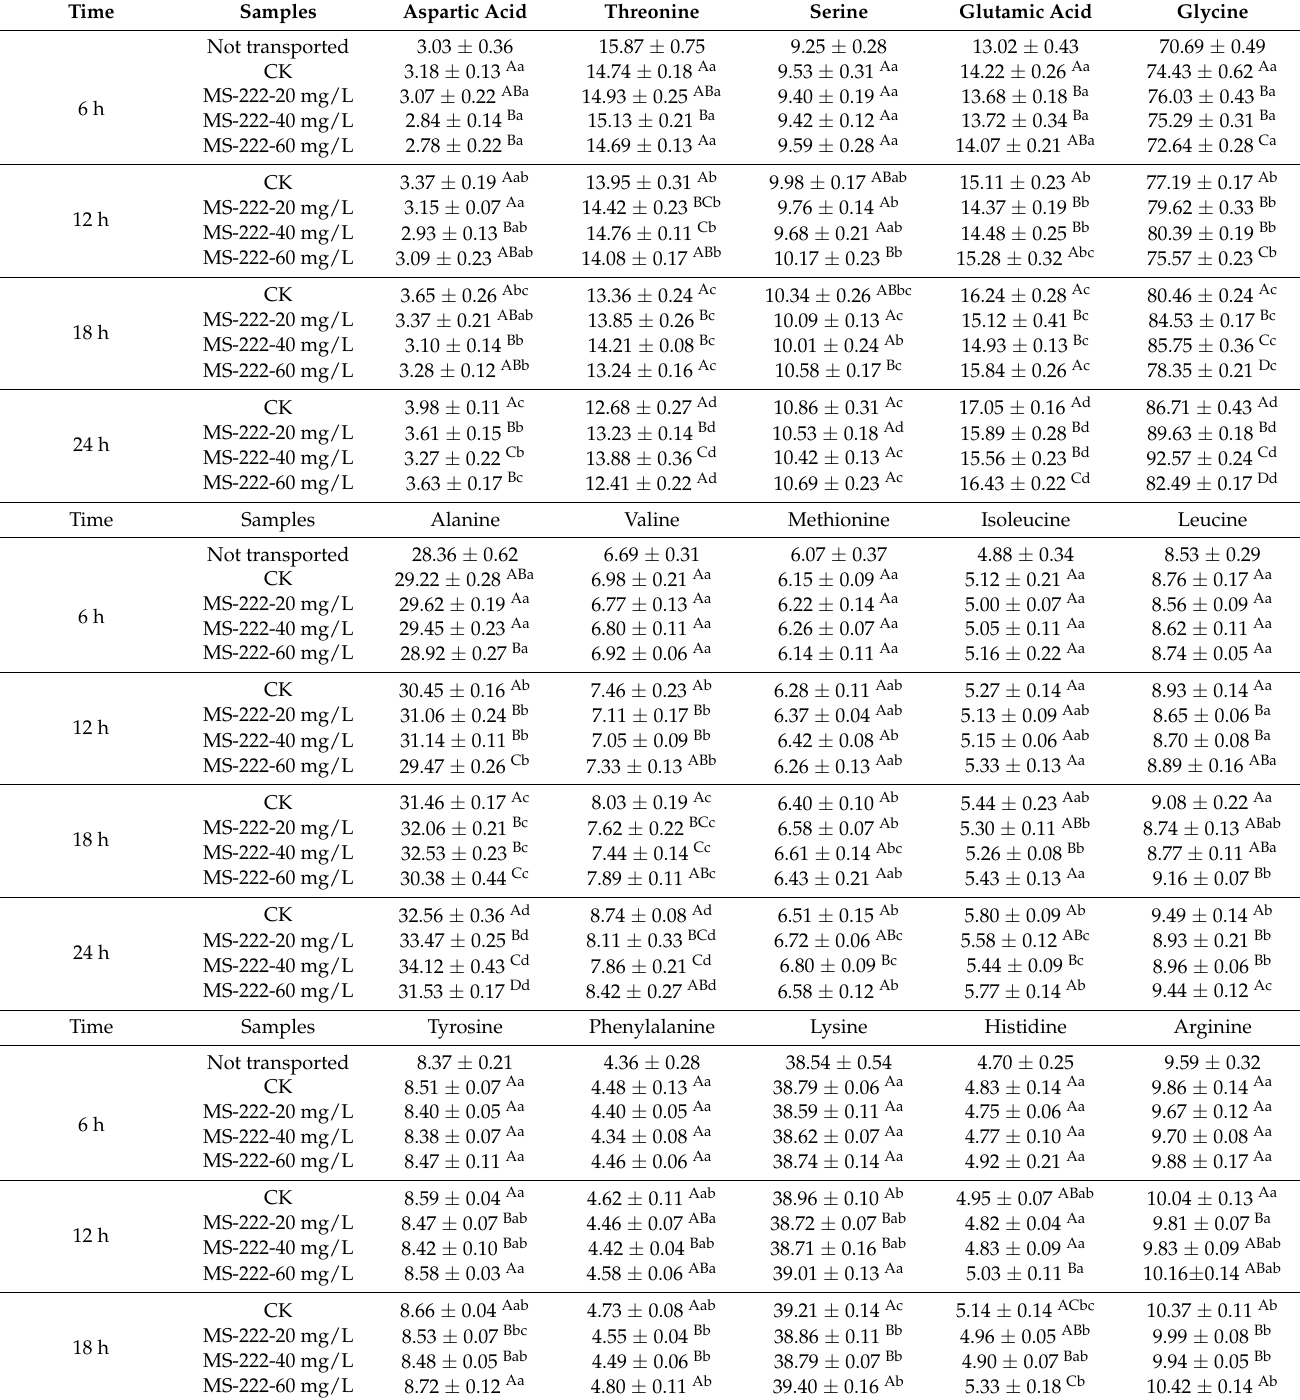
Table 4. Changes in free amino acids in turbot flesh during simulated